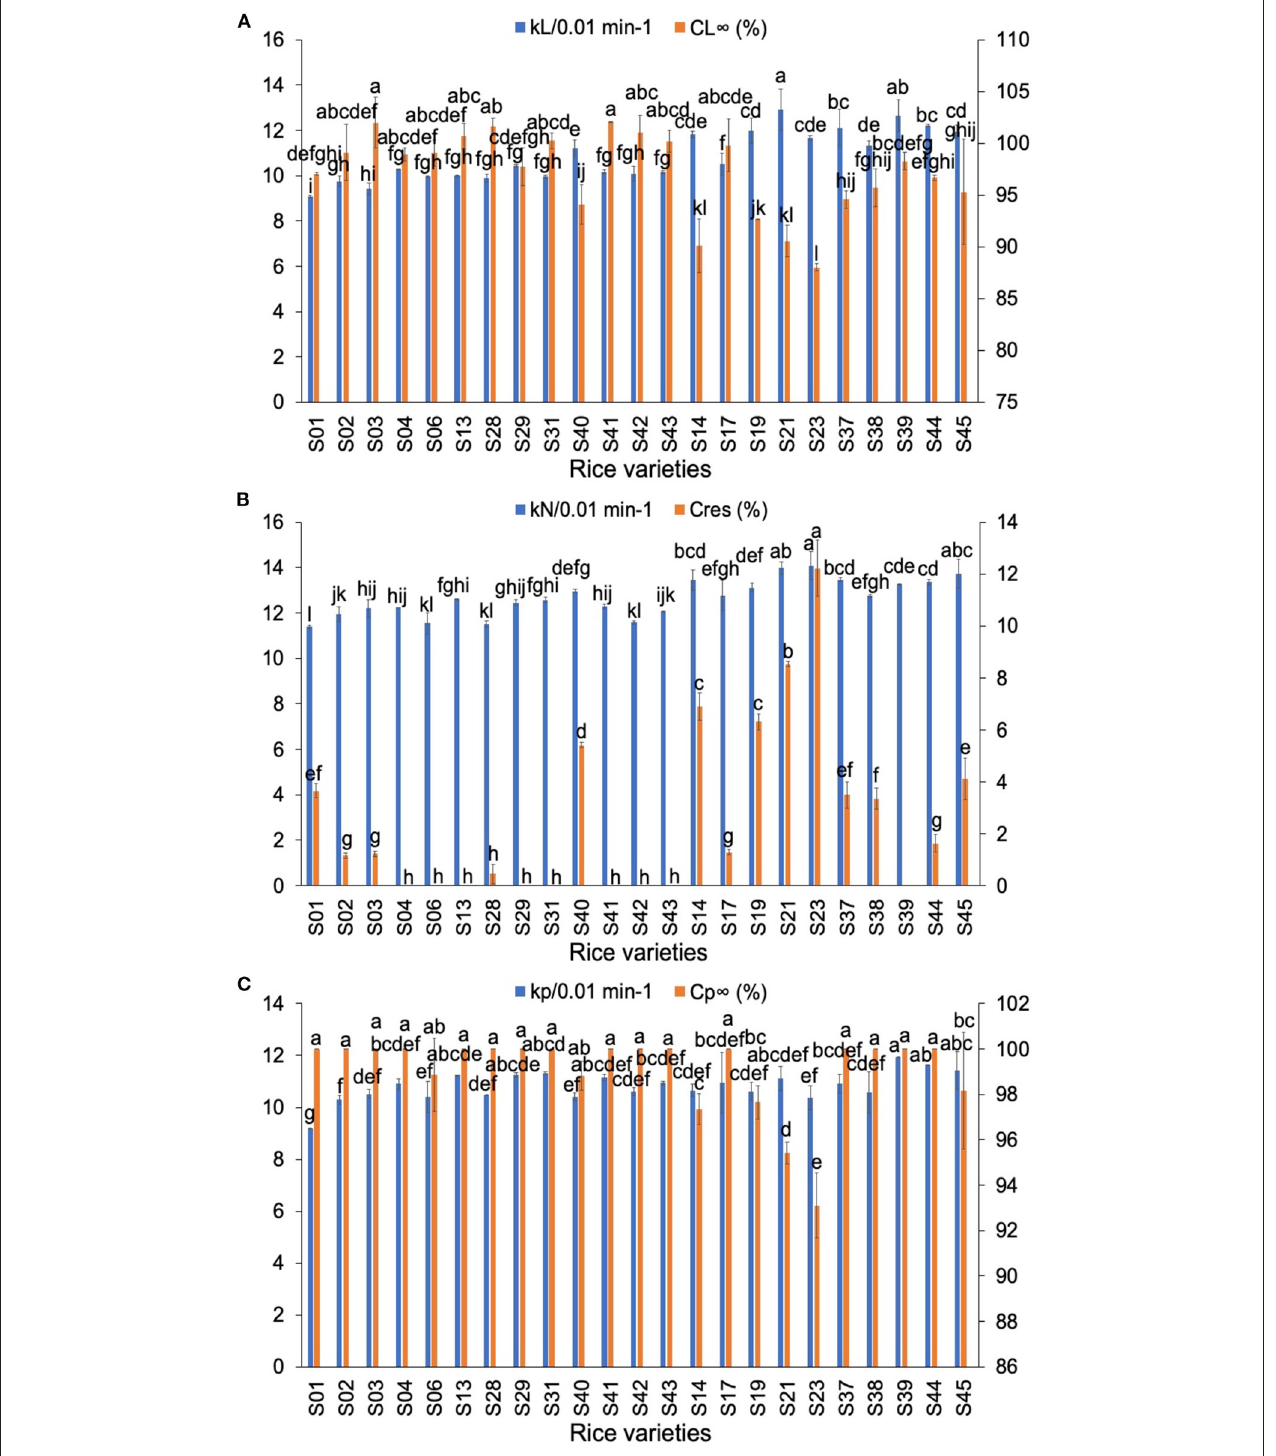
FIGURE 3 | Comparison of in-vitro digestibility parameters of Australian Wild Rices (AWRs) and Domesticated Rices (DRs). (A) The digestion parameters calculated from logarithm of slopes (LoS), (B) the digestion parameters calculated from non-linear least-squares (NLLS), (C) the digestion parameters calculated from parallel models. AWRs consist of S01–S03, indica variety contains S04, S06, S13, S28–S29, S31, S40–S43, and japonica variety contains S14, S17, S19, S21, S23, S37–S39, S44–S45, respectively. k L, k N, and k p are the digestion rate coefficients of starch of LoS, NLLS, and parallel models, respectively. C L ∞ is the percentage of starch digested at very long reaction time of LoS. C res is the fraction of residual starch (starch remaining after an extended digestion period). C p ∞ is the percentage of starch digested at very long reaction time of parallel models. All data were from duplicate measurements. The same letters mean no significant difference ( p < 0.05).